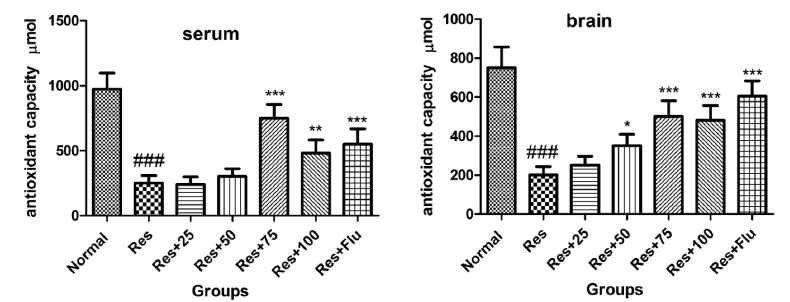
Figure 5. Effects of intraperitoneal injection of four different concentrations of Kelussia odoratissima Mozaffarian extract (25, 50, 75, and 100 mg/kg) on serum and brain antioxidant capacity in mice. Flu= Fluoxetine, Res=reserpine. # Vs. normal group ( ### P < 0.001), * Vs. compared with the reserpine-receiving group ( * P < 0.05, ** P < 0.01, *** P <